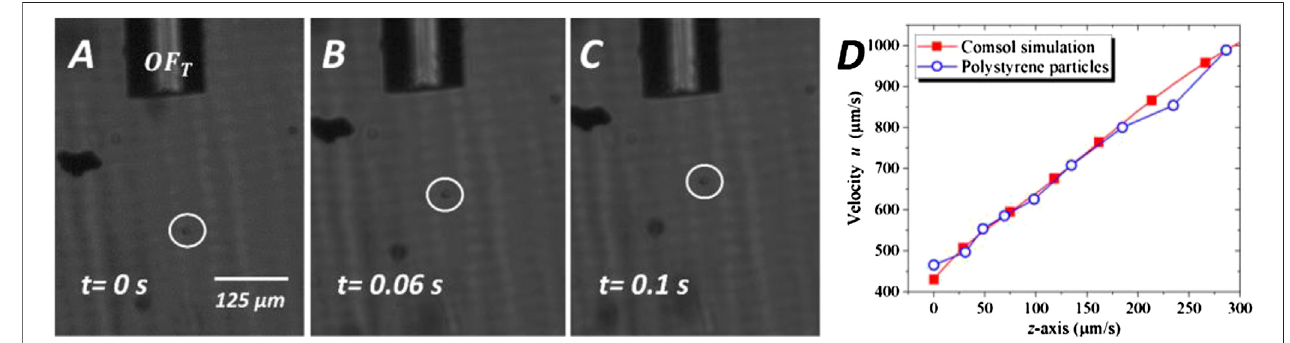
FIGURE5|(A – C) Snapshotsshowthatparticlesmoveinoppositedirectiontothebeampropagationatalaserpower p (cid:1) 2 mW.Whitecirclesindicatetheposition ofaclusterofseveralpolystyrenemicroparticles.( D ) Pro fi le oftheconvectivecurrents ’ velocity asafunction ofpropagation distance z measured fromthe fi ber end.Blue dots correspond to the microparticles ’ velocity whereas red squares correspond to the convective currents obtained from the Comsol simulation.